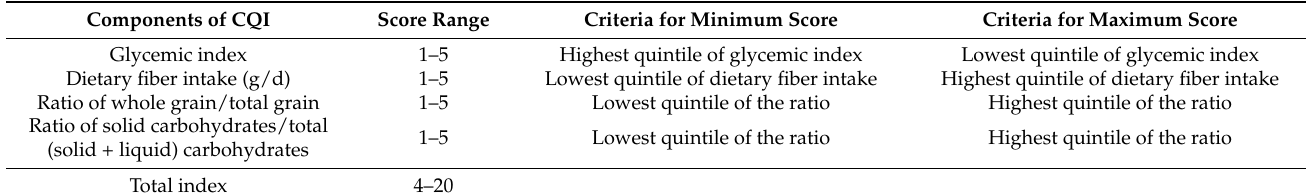
Table 1. Criteria used to calculate carbohydrate quality index